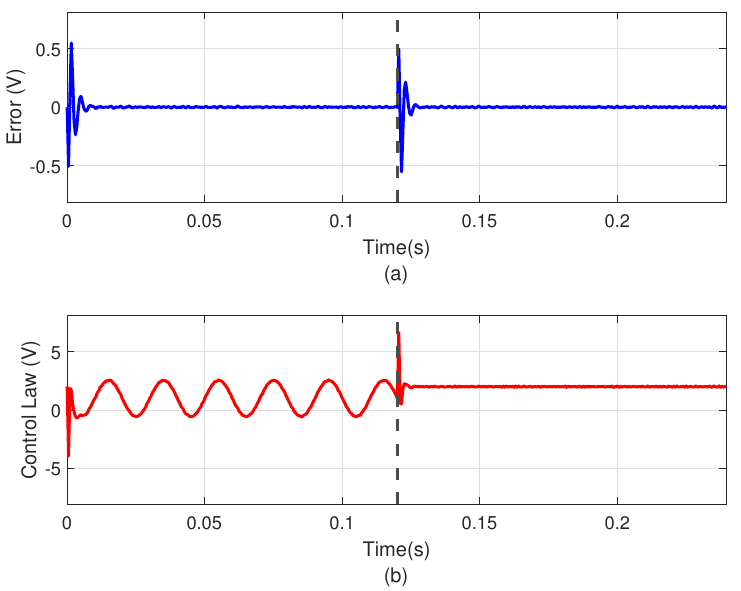
Figure 10. Experimental result for test 2, using p = 40, c = 20, r u = 0.07. ( a ) Error. ( b ) Control